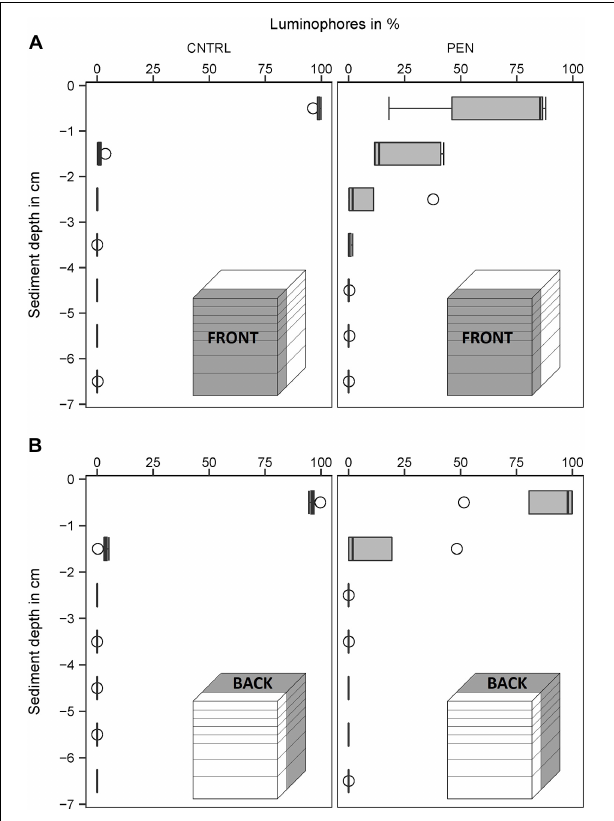
FIGURE 11 | Luminophore distribution (%) as a function of sediment depth (cm) in medium sand with mud-like luminophores. (A) front close to the plate for the CNTRL and PEN treatment. (B) Toward the back of the sediment for the CNTRL and PEN treatment. The box of the boxplot represents the interquartile range, the median is indicated by a line within the box. Whiskers indicate variability outside the interquartile range and circles indicate